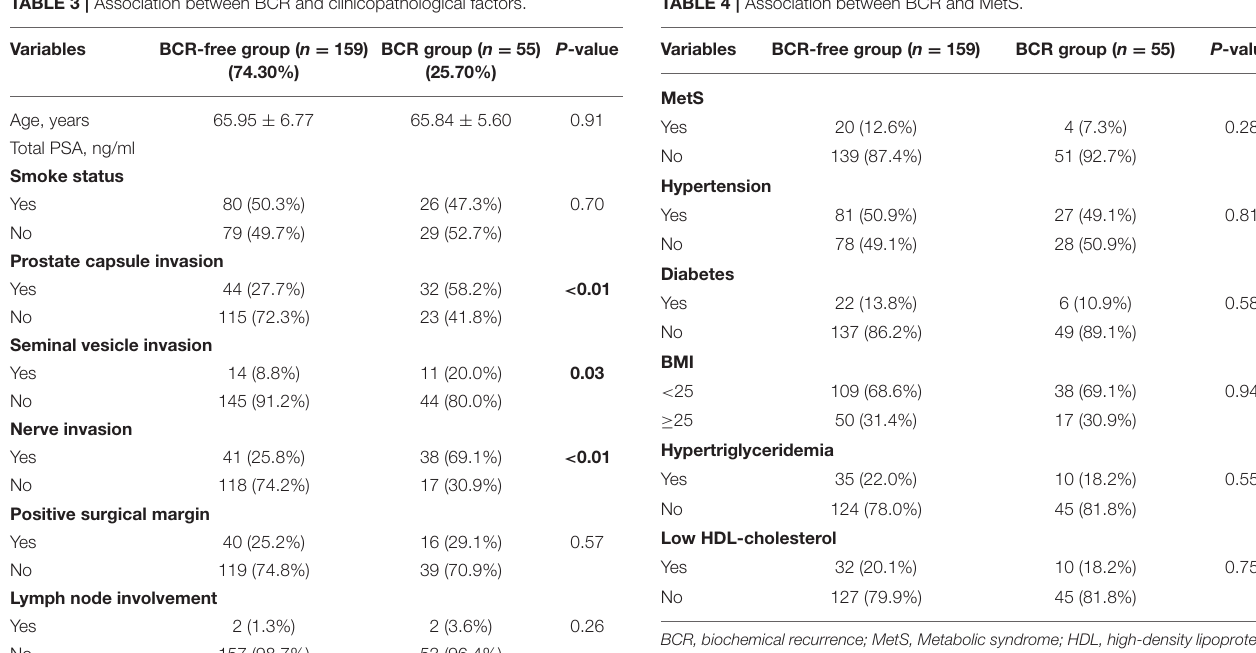
TABLE 4 | Association between BCR and